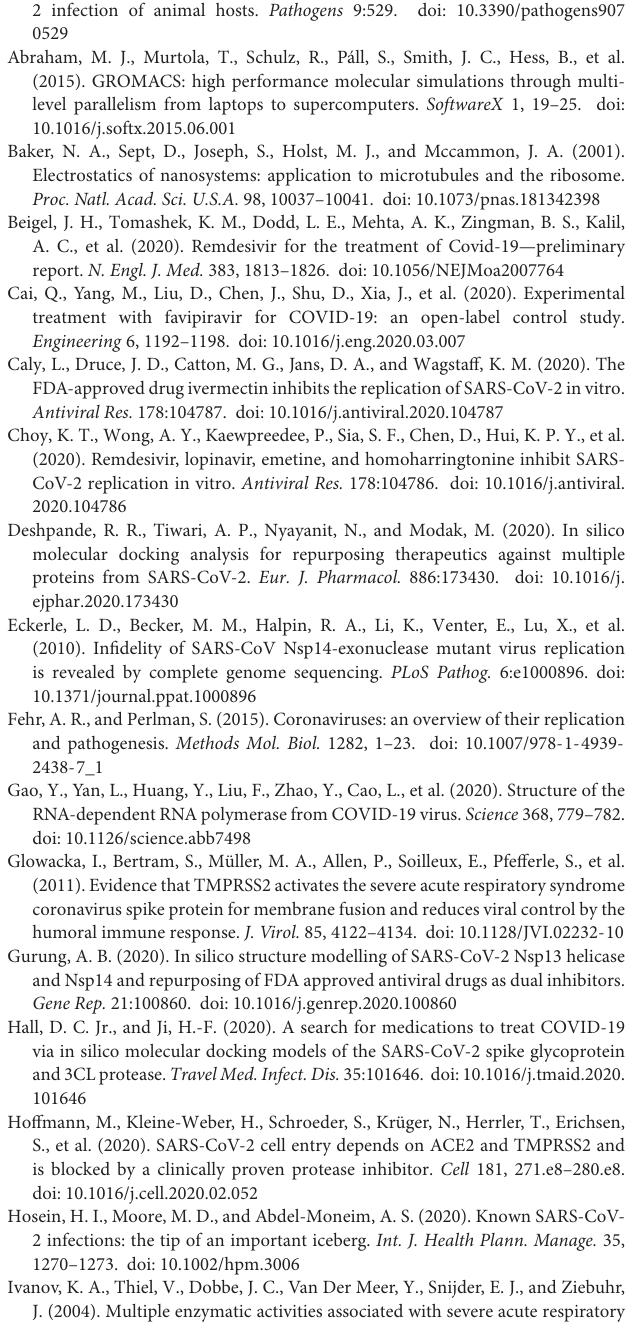
interactions of selected drugs with human TMPRSS2 protein. (A) Camostat, (B) chloroquine, (C) hydroxychloroquine, (D) ivermectin, (E) remdesivir, and (F) favipiravir. Supplementary Figure 3 | RMSD and number of Hydrogen bonds. For every receptor, the RMSD and Hydrogen bonds number for each ligand were